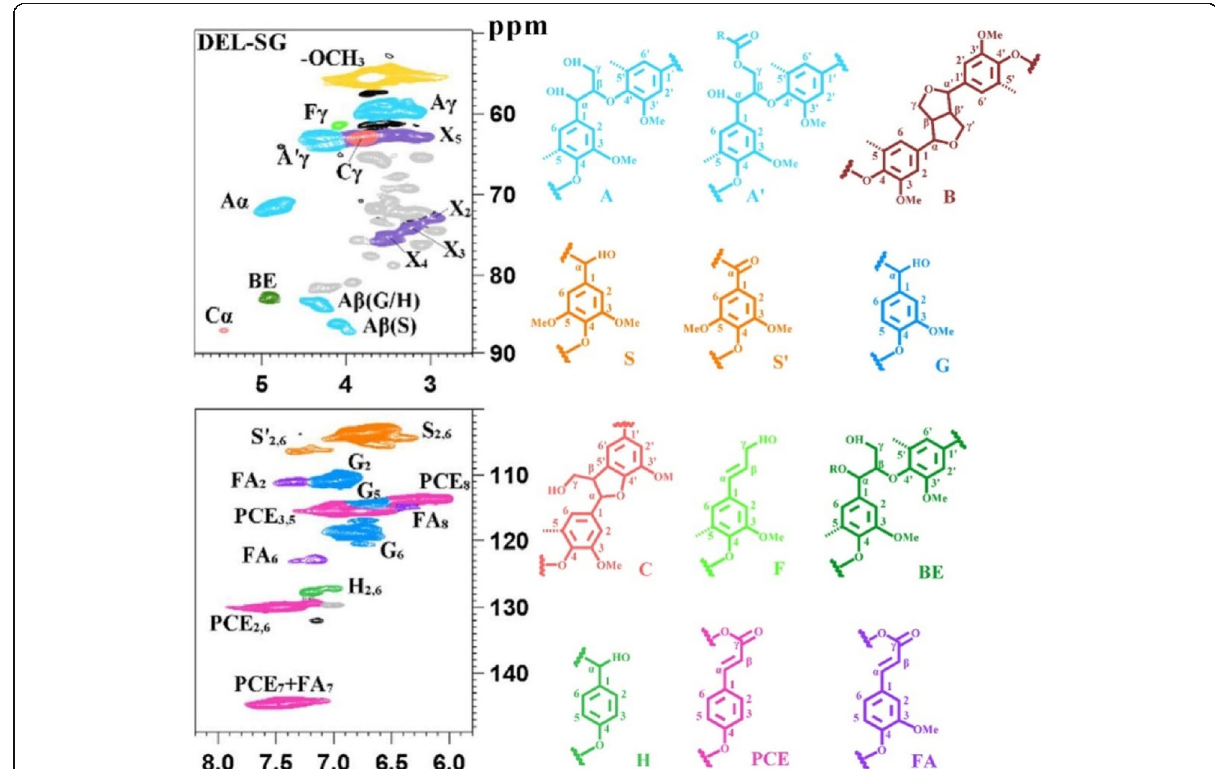
Fig. 5 The typical 2D-HSQC spectra of DEL from Switchgrass and the corresponding major substructures. Reprinted with permission from ref.